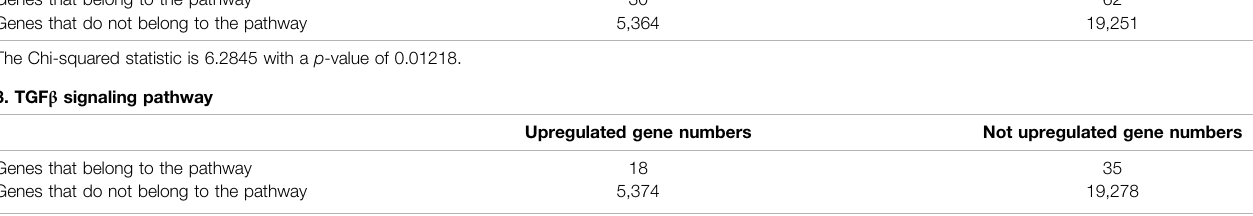
Figure 2A plots the “ vasopressin-regulated water reabsorption ” KEGG pathway. Among the 22 components in the pathway, 11 of them showed decreases in transcript abundance in the glucocorticoid receptor knockdown cells by RNA-seq analysis. Table 5 lists all components in the pathway. Also, four of them were elected for quantitative RT-PCR validation: vasopressin V2 receptor (Avpr2), guanine nucleotide-binding protein G(s) subunit α (Gnas), adenylyl cyclase type 6 (Adcy6), and cyclic AMP-responsive element- binding protein 3 (Creb3). Quantitative RT-PCR showed glucocorticoid receptor knockdown cells ( Figure 2B , shGR1 and shGR2), and reduction in the Adcy6 transcript level in one glucocorticoid receptor knockdown cell ( Figure 2D , shGR2). No change was found in the Gnas ( Figure 2C ) and Creb3 ( Figure 2E ) transcript levels in the glucocorticoid receptor knockdown cells. The previous observations suggest that the glucocorticoid receptor maintains the Avpr2 expression. This was reassured by the expression of Avpr2 in the cells